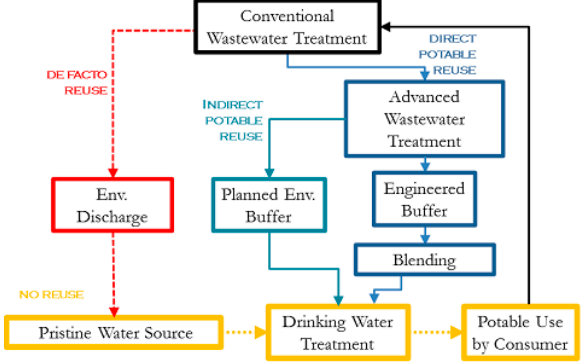
Figure 1. Potable reuse paradigms showing unintended de facto reuse and Direct Potable Reuse with blending prior to conventional drinking water treatment. This paper explores the impact of surface water quality (de facto reuse) and blending on the overall microbial risk to the consumer.